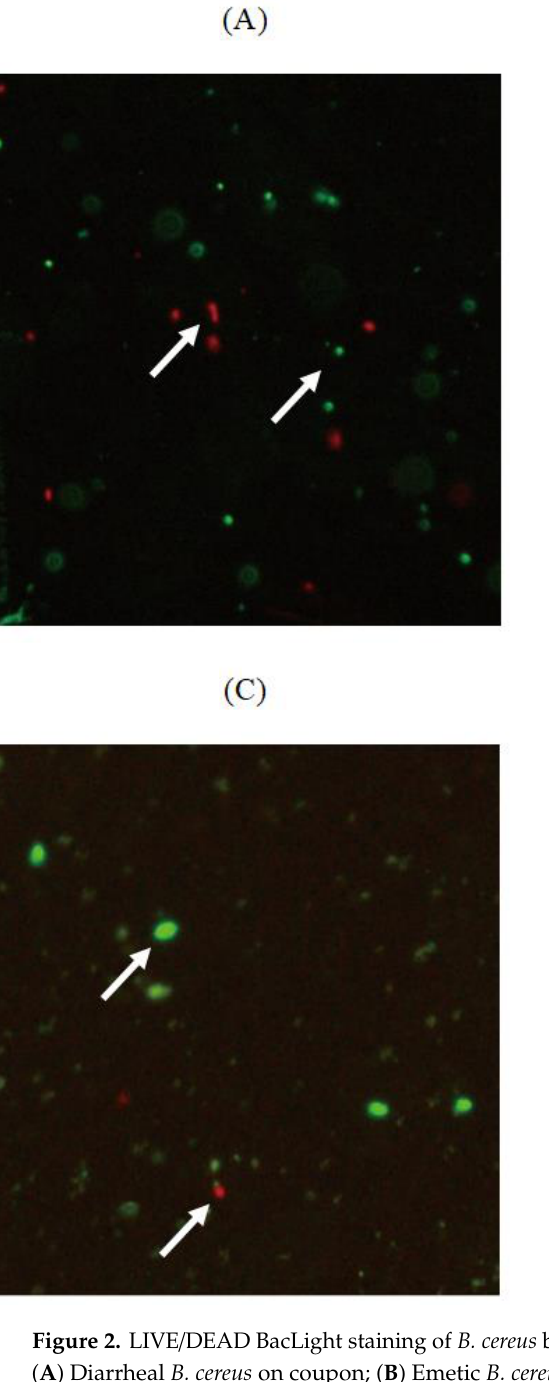
Figure 2 . LIVE/DEAD BacLight staining of B. cereus biofilm cells on the stainless-steel surface and tofu ( A ) Diarrheal B. cereus on coupon; ( B ) Emetic B. cereus on coupon; ( C ) Diarrheal B. cereus on tofu; ( D ) Emetic B. cereus on tofu. White arrow indicates the live (green) or dead (red) cells